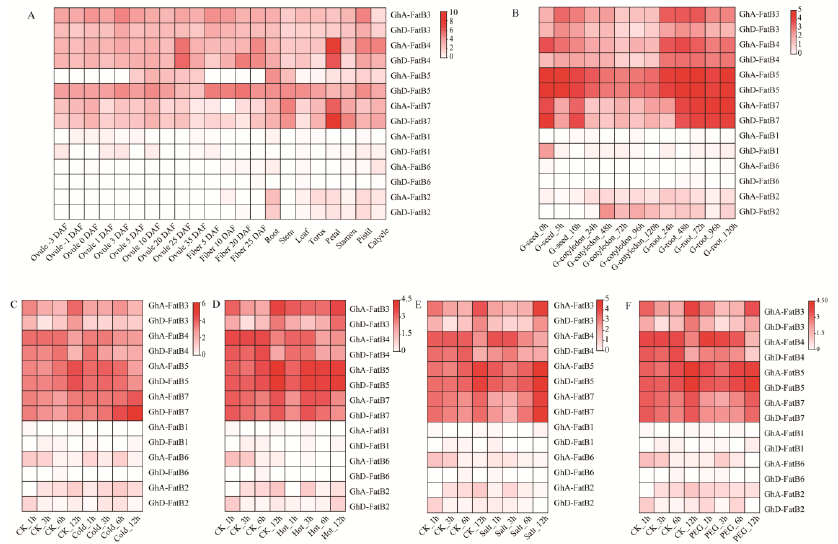
Figure 4. Transcriptional expression patterns of 14 GhFatB genes in various cotton tissues. The mRNA abundance was measured by the FPKM value (Fragments per kilobase of transcript per million mapped reads). The high value of FPKM represents the high expression level. The darkness of red color indicates the expression level. ( A ) Expression levels of 14 GhFatB genes in various cotton tissues including developing ovules ( −3, −1, 0, 1, 3, 5, 10, 20, 25 and 35 DAF), developing fibers (5, 10, 20 and 25 DAF), vegetable tissues (root, stem, and leaf) and flower tissues (torus, petal, stamen, pistil, and calycle). ( B ) Expression levels of 14 GhFatB genes in various tissues of cotton seed germination including germinating seeds (0, 5, and 10 h), cotyledon (24, 48, 72, 96, and 120 h) and roots (24, 48, 72, 96, and 120 h). ( C – F ) Expression levels of 14 GhFatB genes in cotton leaves treated with cold stress ( C ), hot stress ( D ), salt stress ( E ) and drought stress ( F ), respectively. All the RNA-seq data used here were obtained from the Cottonfgd database (https://cottonfgd.org/) (accessed on 6 October 2021).